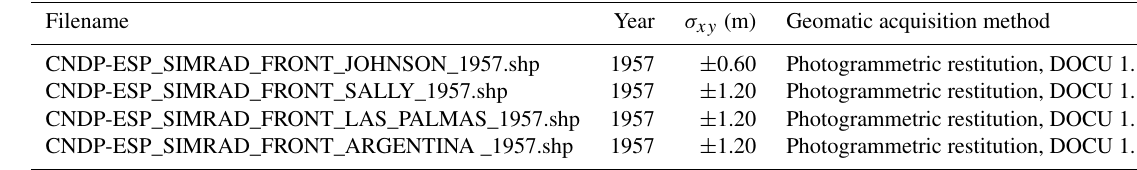
Table 2. ARCGIS shape files for the BAS photogrammetric flight of 1957. In the third column the RMS error is shown.